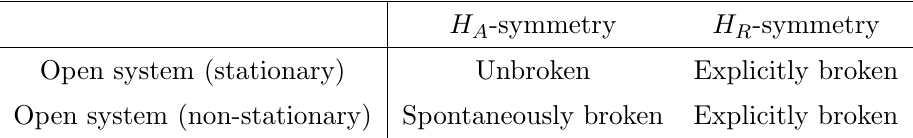
Table 1 . Symmetry structure in open systems: because of the doubled symmetry in the Schwinger- Keldysh formalism, we need to discuss the H A and H R symmetries separately. In open systems, the H R symmetry is explicitly broken, whereas the H A symmetry is unbroken/spontaneously broken in the stationary/non-stationary backgrounds. It is in a sharp contrast to the closed system at the zero temperature, where the dynamics is described by the Hamiltonian of the total